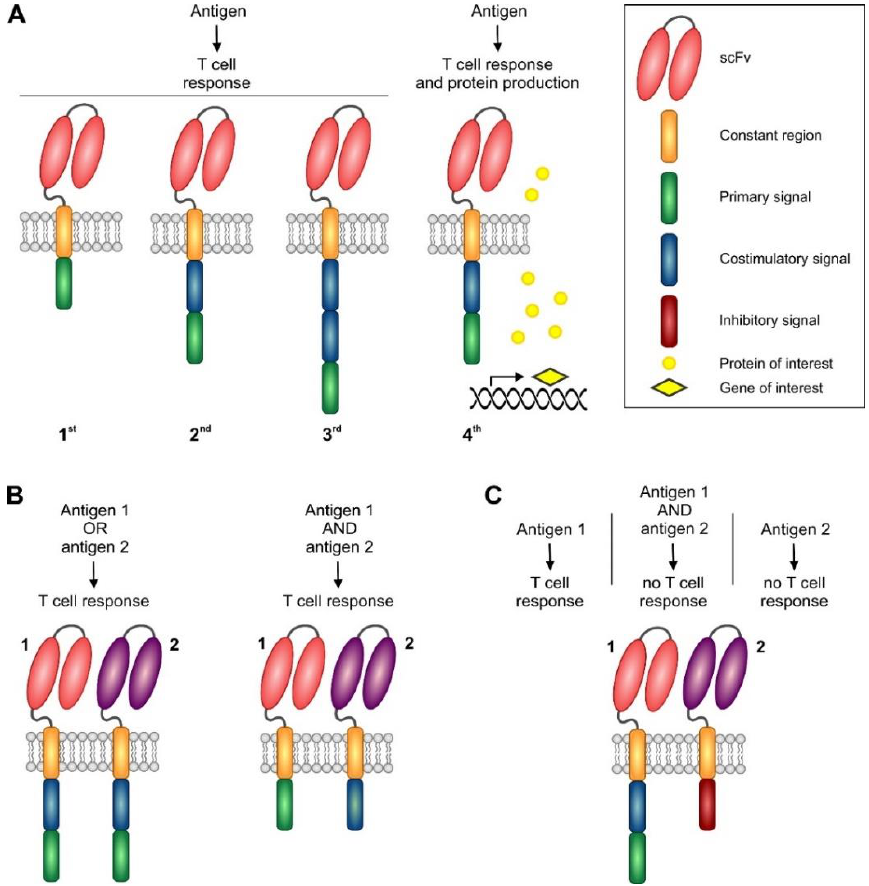
Figure 4. Schematic representation of design of four generations of CAR. Legend: Conventional CARs: ( A ) 1st to 3rd generation are defined by their signaling domains: a primary signaling domain only (1st generation); signaling and co-stimulatory domains (2nd generation); combined co-stimulatory domains (3rd generation); a release of activating cytokine upon CAR engagement (4th generation). Co-expression of two di ff erent CARs: ( B ) engagement of either CAR triggers downstream activation (left); engagement of both CARs triggers downstream activation (right); ( C ) engagement of inhibitory CAR prevents T-cell activation in the presence of cells that express the target antigen